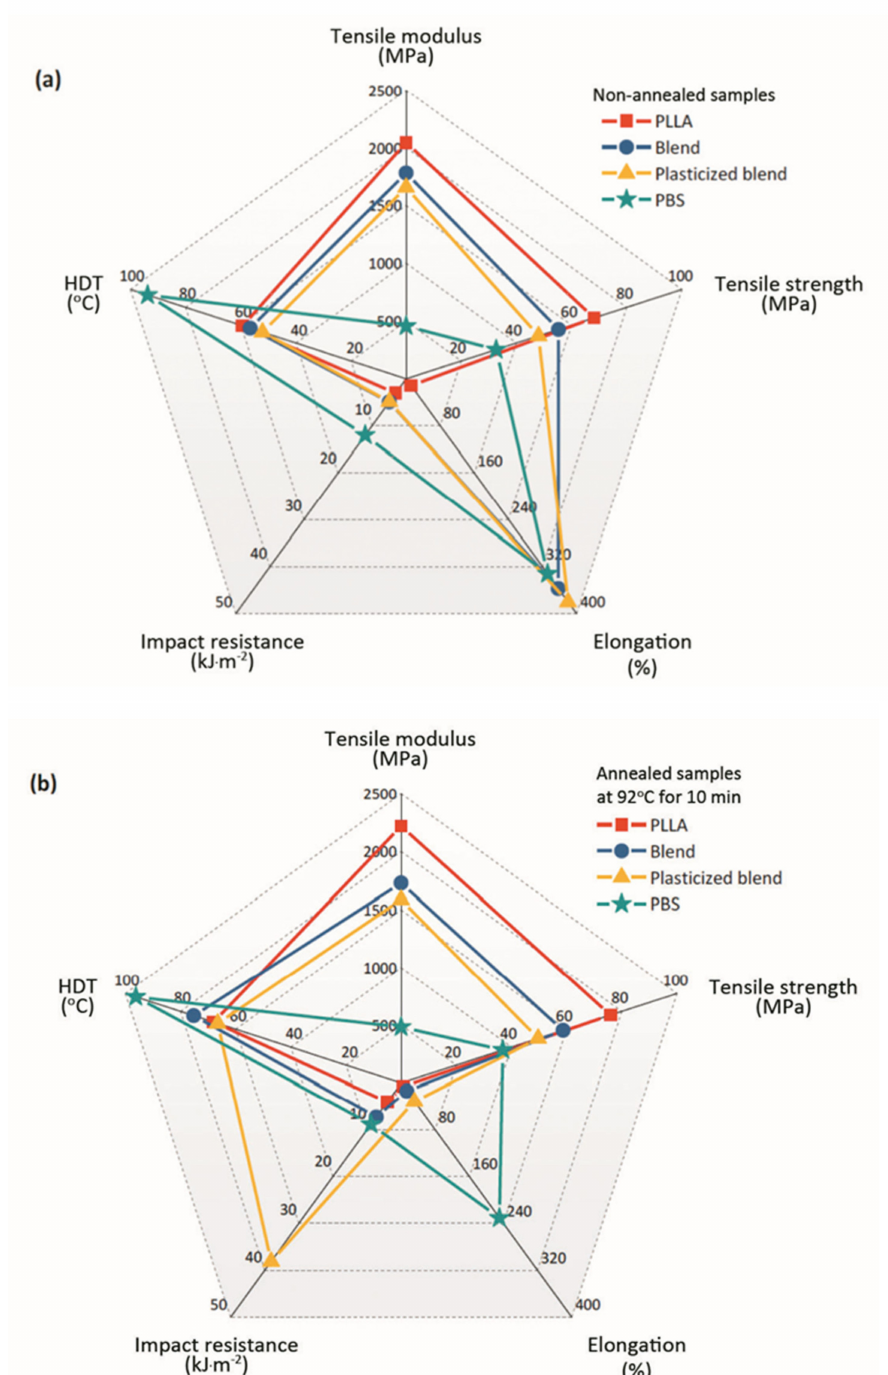
Figure 6. Overall performance of non-annealed samples ( a ), and of annealed samples (at 92 ◦ C 10 min) ( b